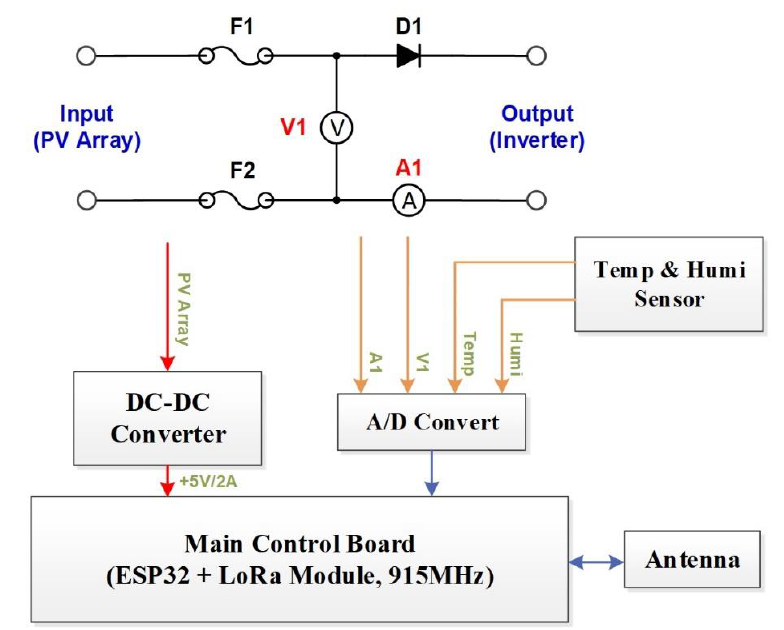
Figure 2. The configuration of the TX module in proposed PV junction box.